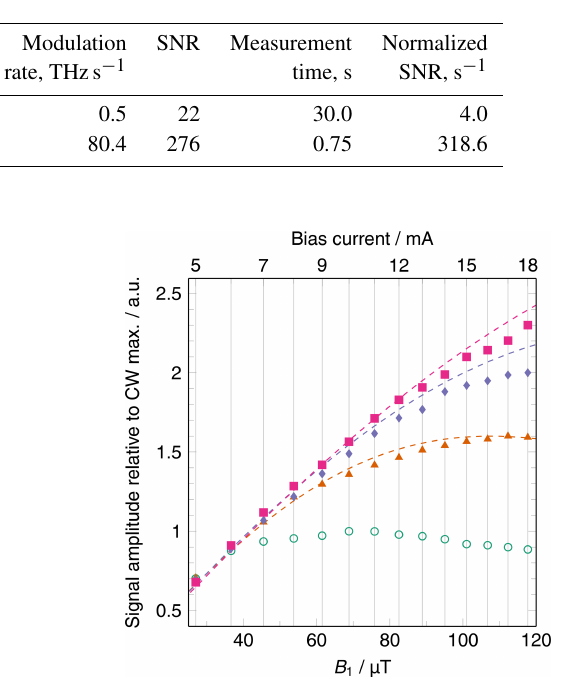
Figure 4. Signal amplitudes of CW-EPRoC (green circle) and tran- sient RS-EPRoC for three scan rates (80.4THzs − 1 , orange triangle; 201.1THzs − 1 , purple diamond; and 402.1THzs − 1 , pink square) as a function of bias current ( x axis, top) and corresponding B 1 magnitudes ( x axis, bottom). The dashed lines are simulations of the RS